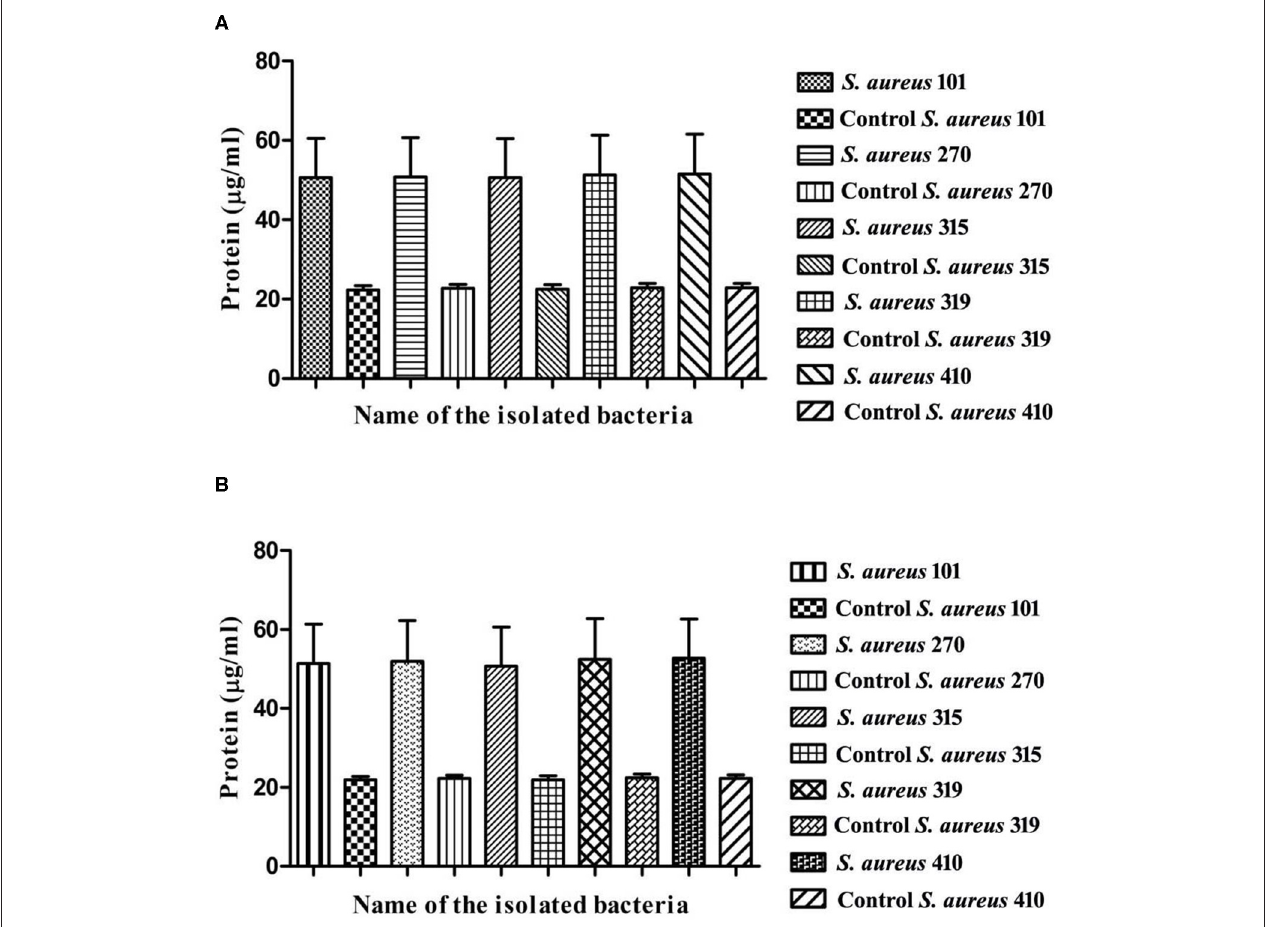
FIGURE 3 | (A) Protein leakage assay of arborine compound on different MDR Staphylococcus aureus strains. (B) Protein leakage assay of skimmianine compound on different MDR Staphylococcus aureus